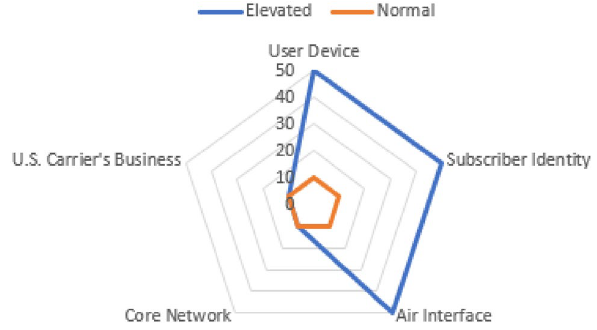
Fig. 8 Device/identity tracking risk